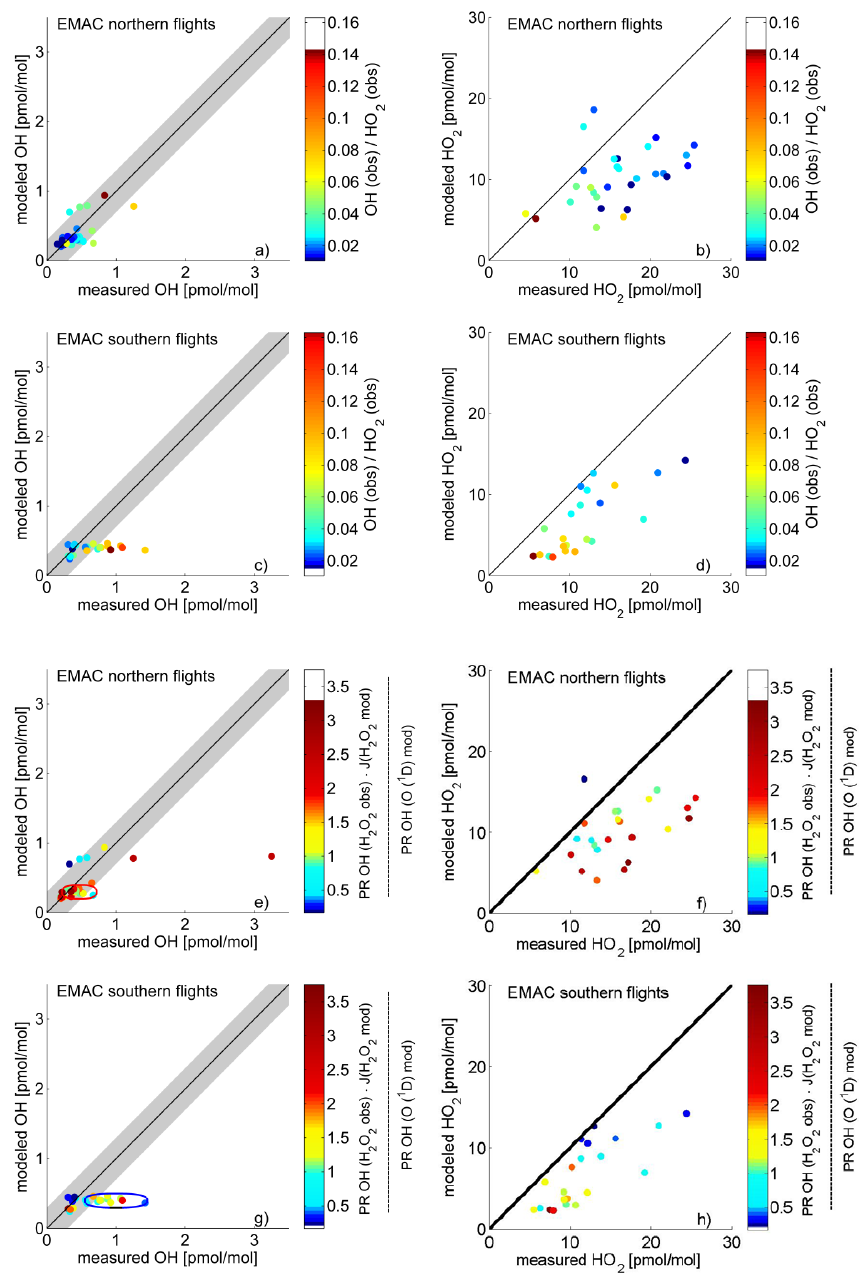
Figure 11: Comparison of model simulation to observed OH and HO 2 mixing ratios. Colour coding highlights the conversion ratio and the ratio of primary production rates. The 1:1 lines are given in black.